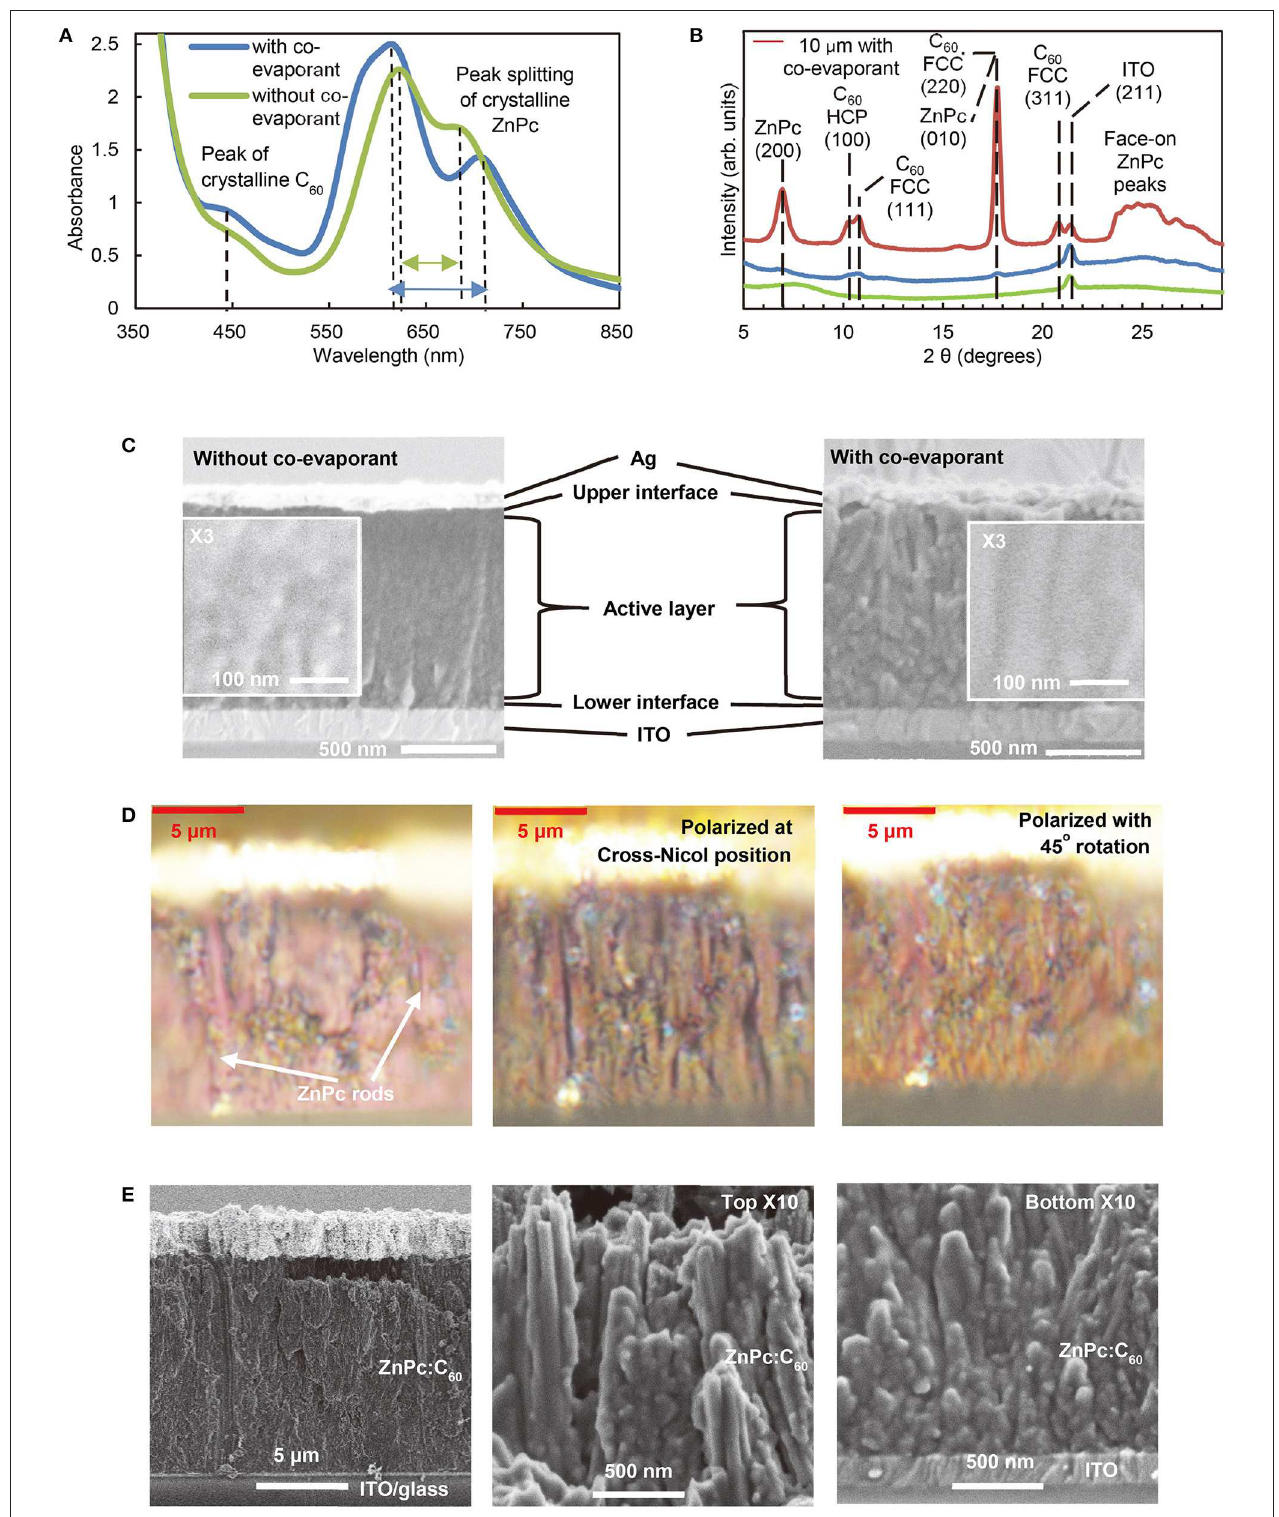
FIGURE 4 | Effects of co-evaporant on ZnPc:C 60 blend films. (A) UV-Vis-NIR absorbance spectra of 400nm film converted from transmittance, (B) XRD patterns of 600nm, and (C) Cross-sectional SEM images of 1,000nm ZnPc:C 60 with/without co-evaporant. Additionally, (B) includes the 10- µ m-thick ZnPc:C 60 cell with co-evaporant, whose cross-section was observed as the epi-illuminated optical microscope image and the polarized microscope images (D) , and the SEM images (E) .